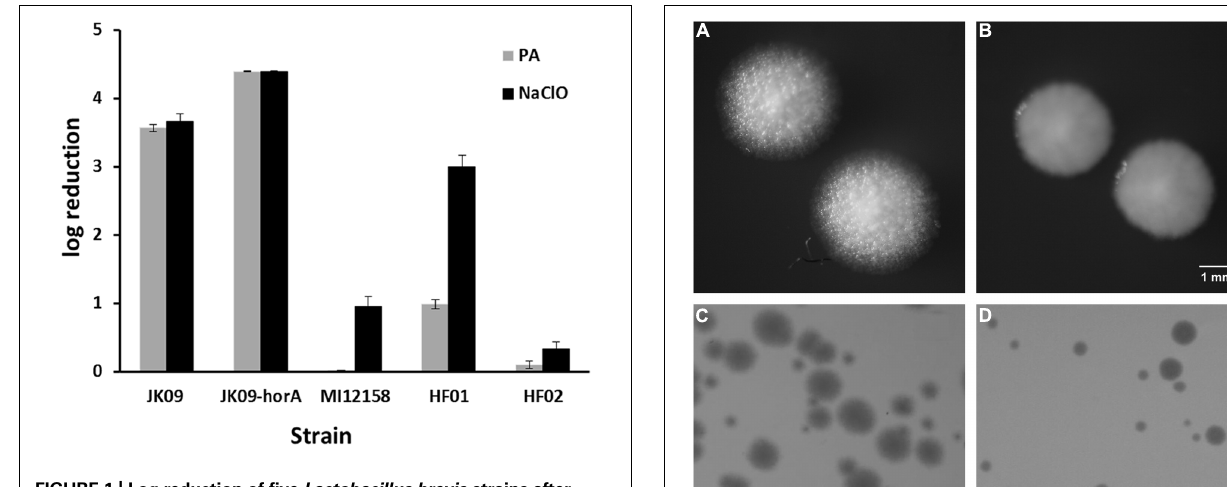
all the strains after anaerobic cultivation was 8.72 ± 0.10 (mean